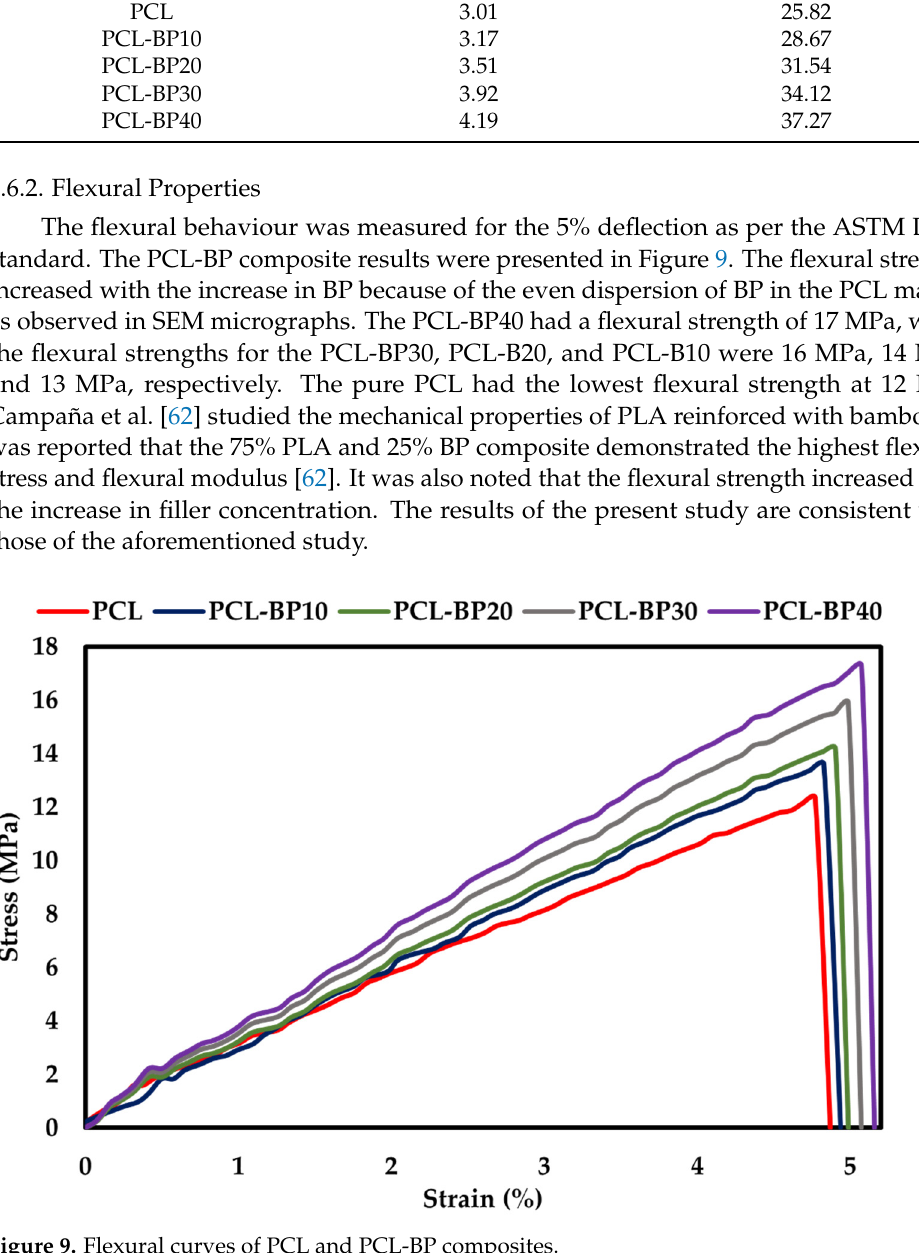
Figure 10. Images of hardness for PCL and PCL-BP composites: ( a ) PCL; ( b ) PCL-BP10; ( c ) PCL- BP20; ( d ) PCL-BP30; ( e ) PCL-BP40; and ( f ) Vickers hardness values ( n = 3, * p ≤ 0.05, ** p ≤ 0.01).